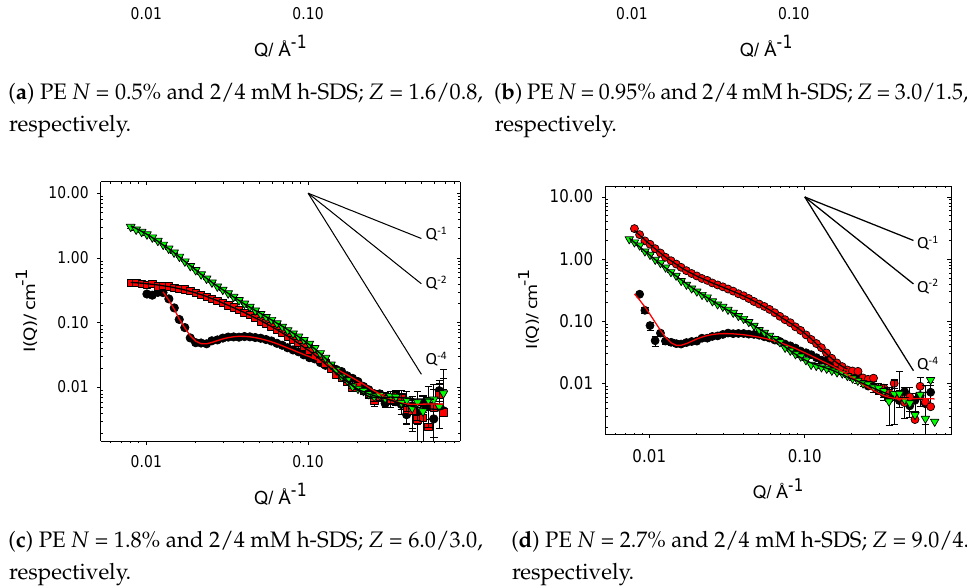
Figure 4. SANS profiles from binary mixtures containing 1 wt% cat-HEC polymers with different degrees of charge modification and h-SDS (full contrast). Symbols: circles, no SDS; squares, 2 mM SDS; down triangles, 4 mM SDS. The solid lines show Q − 1 , Q − 2 and Q − 4